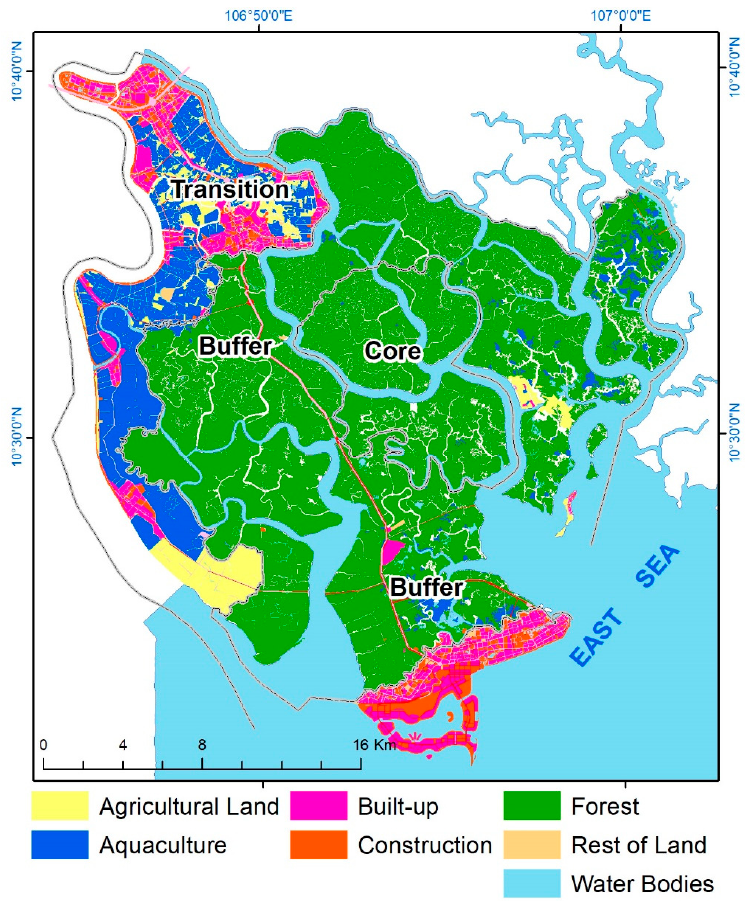
Figure 7. Proposition for land use in Can Gio district (red and pink) with a scale of 1:5000 in 2025 [18].